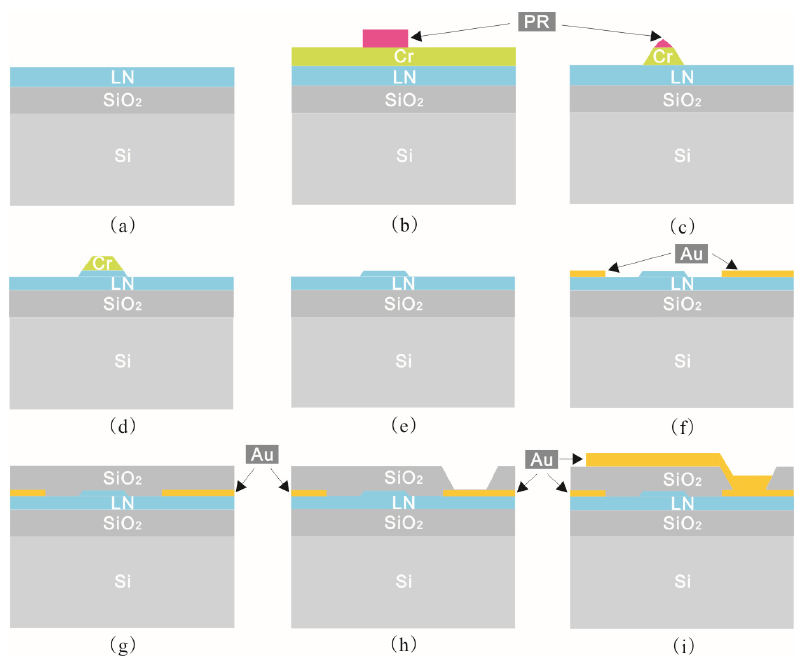
Figure 3. Schematic diagram of the fabrication process of the TFLN electro-optical modulator. ( a ) x-cut LNOI substrate is ( b ) coated with 80 nm thick Cr by magnetron sputter. Then a 1.2- µ m-thick negative PR is used to define the waveguide pattern. ( c ) The patterns are then transferred into the Cr Cr/900 nm-thick Au) are formed using a standard lift-off process. ( g ) A 1 µ m thick silica cladding process is performed to produce the top